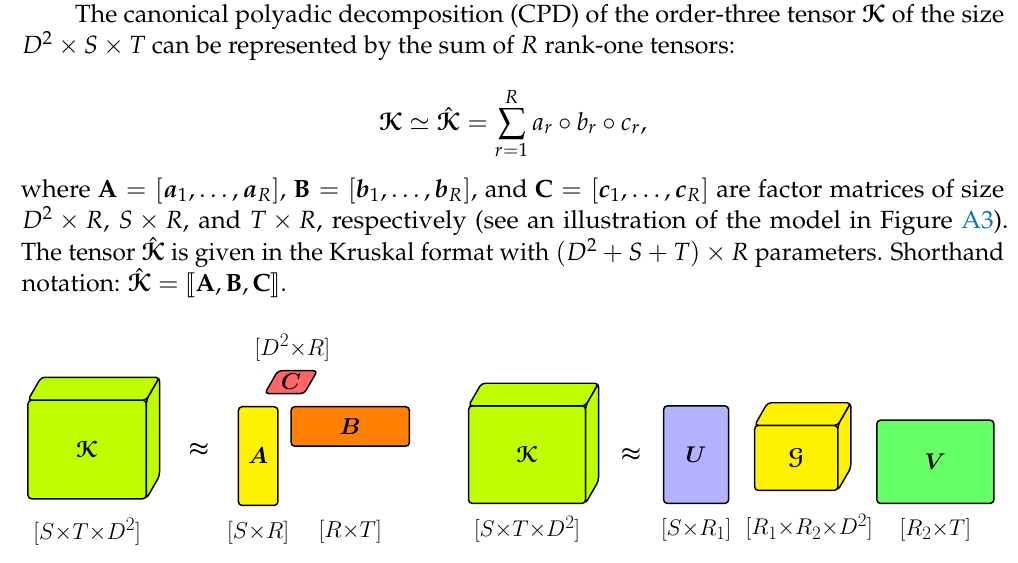
Figure A3. Decomposition of a third-order tensor into ( left ) canonical polyadic tensor decomposition (CPD) with three-factor matrices and ( right ) Tucker two-tensor decomposition